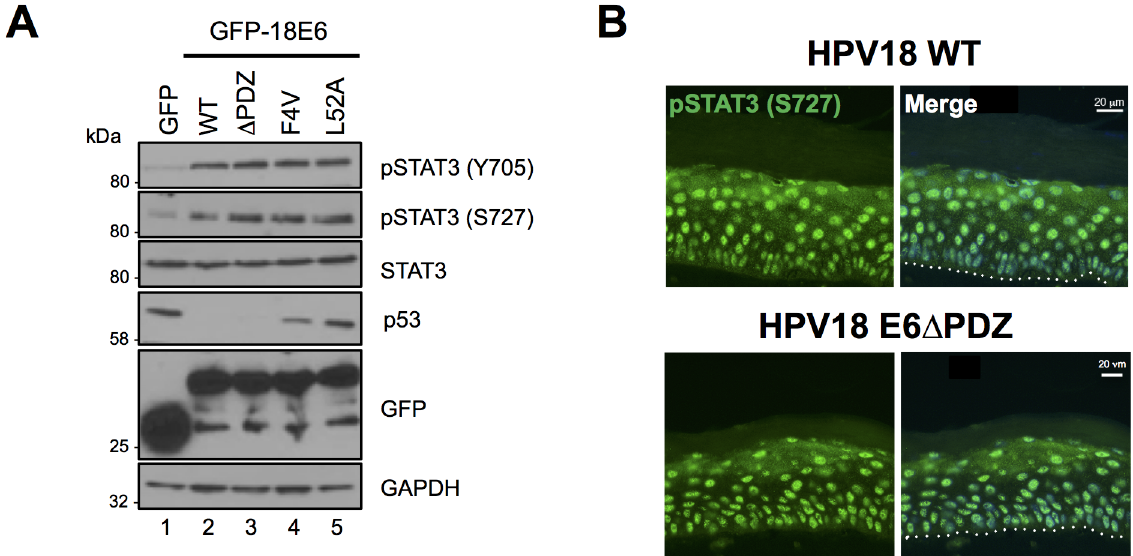
Fig 3. STAT3 is phosphorylated in cells expressing E6 defective for E6AP binding, p53 degradation and PDZ domain binding. A) Representative western blot of C33a cells transfected with GFP or GFP tagged HPV18 E6 wild type, E6 Δ PDZ, E6 F4V or E6 L52A and analysed using antibodies detecting total and phosphorylated STAT3 and p53. GAPDH expression was used as a loading control and GFP confirmed expression of the E6 proteins. Data presented are representative of at least three independent experiments. B) Organotypic raft sections were stained with an antibody specifically detecting STAT3 pS727 (green) and counterstained with DAPI to highlight the nuclei (blue—in merged panels). Images were acquired with identical exposure times. The dotted line indicates the basal cell layer. Scale bar, 20 μ m.